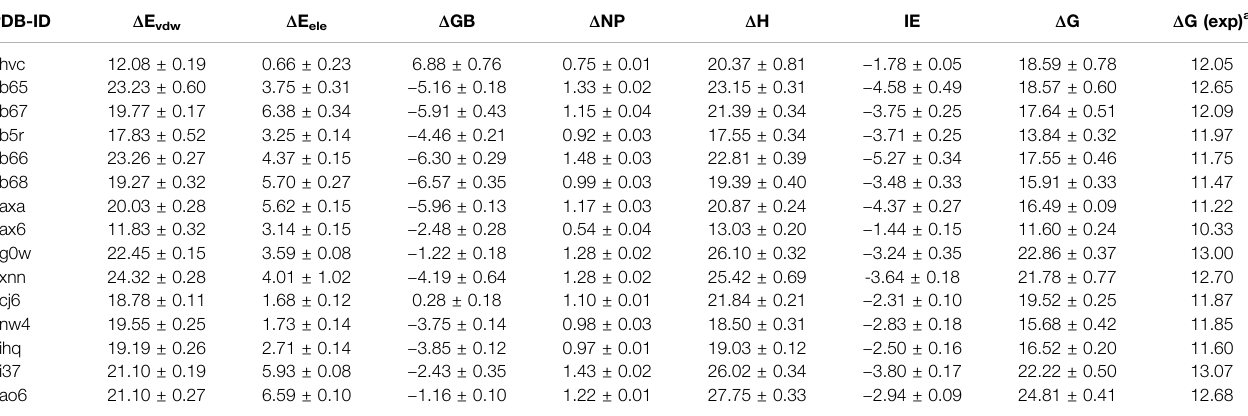
TABLE 3 | Free energy components of the binding energies (kcal/mol). PDB-ID